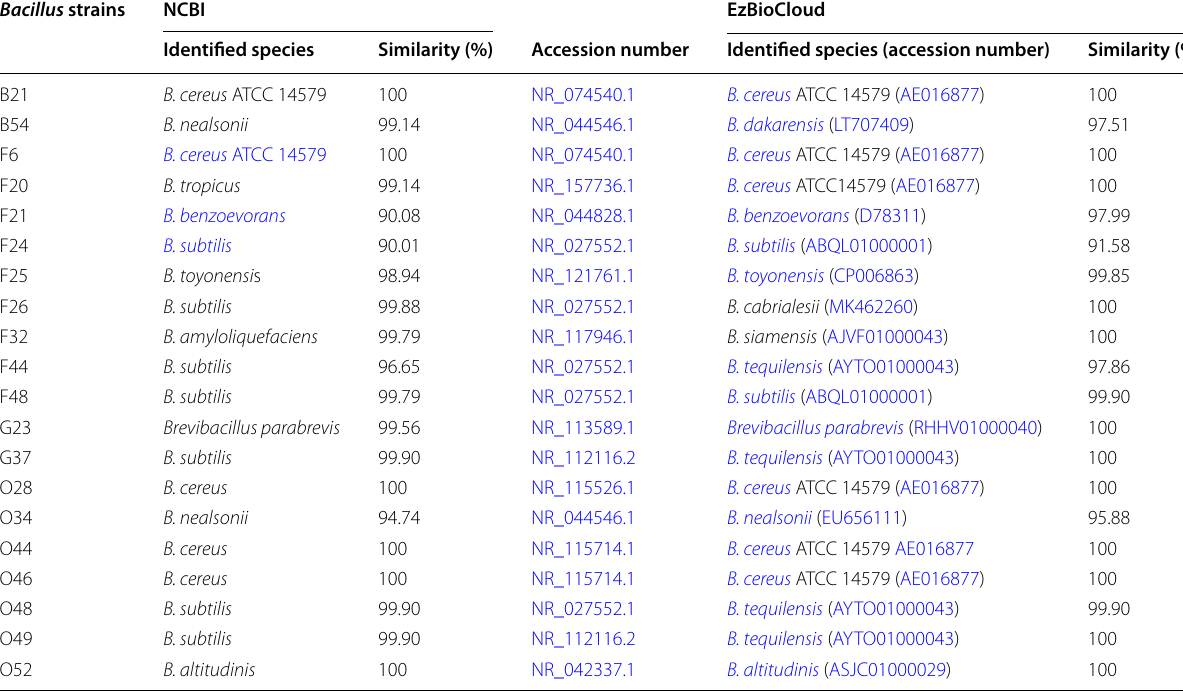
Table 1 Comparative taxonomic identification of Bacillus species by 16S rRNA